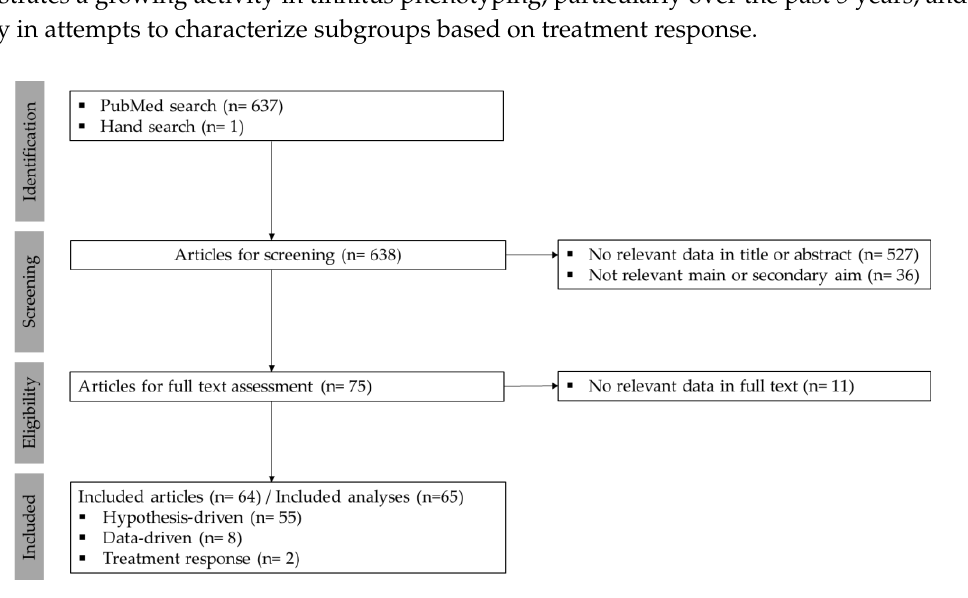
Figure 1. Preferred Reporting Items for Systematic Reviews and Meta-Analyses (PRISMA) flow diagram for screening and selection process.